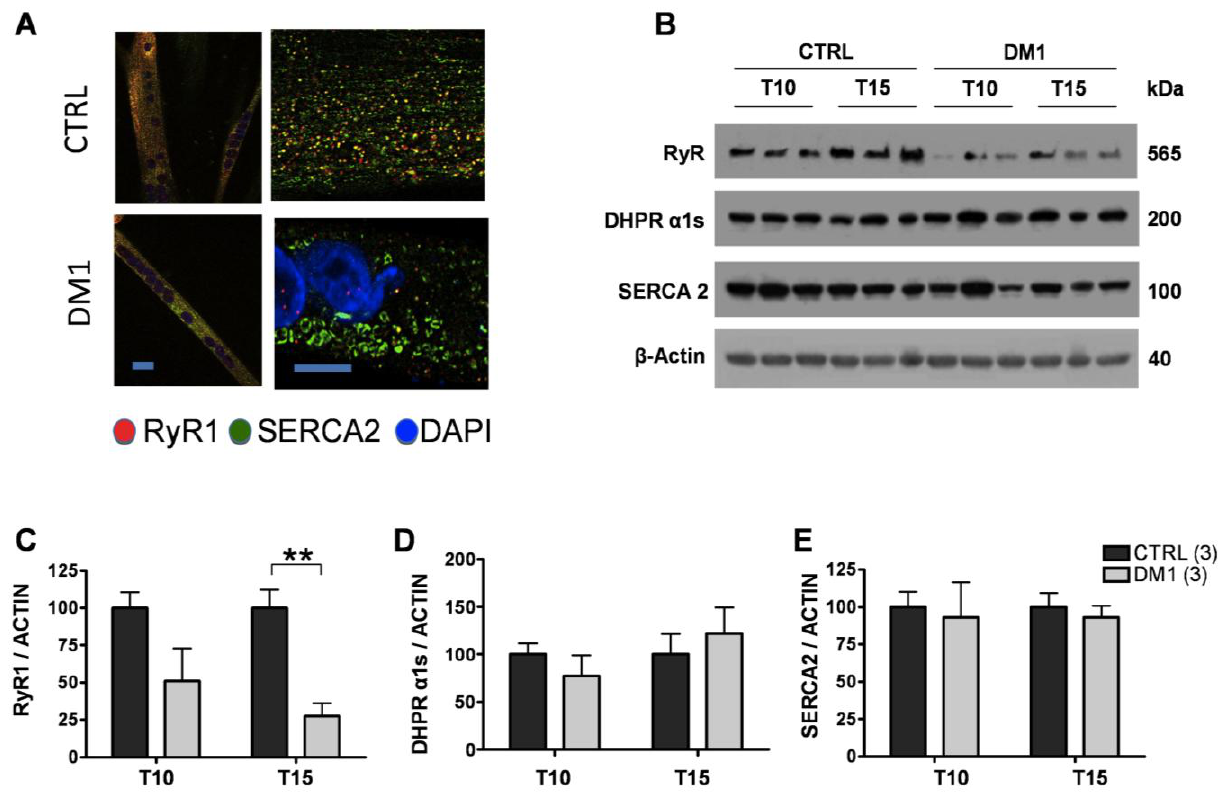
Figure 4. Expression of Ca 2+ channels and transporters in control and DM1 myotubes at 10 (T10) and 15 (T15) days of differentiation. ( A ) Representative images of SERCA2 (green) and RyR1 (red), nuclei (blue-Dapi) immunofluorescence of T15 differentiated control and DM1 myotubes. Scale bar is 10 (cid:541)(cid:80)(cid:17)(cid:3) (cid:11) B ) Representative Western blot analysis of RyR1, (cid:39)(cid:43)(cid:51)(cid:53)(cid:3) (cid:302)(cid:20)(cid:86)(cid:3) (cid:11)(cid:38)(cid:68)(cid:89)(cid:20)(cid:17)(cid:20)(cid:12)(cid:3) (cid:68)(cid:81)(cid:71)(cid:3) (cid:54)(cid:40)(cid:53)(cid:38)(cid:36)(cid:21)(cid:3) (cid:82)(cid:73)(cid:3) (cid:70)(cid:82)(cid:81)(cid:87)(cid:85)(cid:82)(cid:79)(cid:3) (cid:68)(cid:81)(cid:71)(cid:3) (cid:39)(cid:48)(cid:20)(cid:3) (cid:80)(cid:92)(cid:82)(cid:87)(cid:88)(cid:69)(cid:72)(cid:86)(cid:3) (cid:68)(cid:87)(cid:3) (cid:20)(cid:19)(cid:3) (cid:68)(cid:81)(cid:71)(cid:3) (cid:20)(cid:24)(cid:3) (cid:71)(cid:68)(cid:92)(cid:86)(cid:3) (cid:82)(cid:73)(cid:3) differentiation. ( C (cid:177) E (cid:12)(cid:3) (cid:52)(cid:88)(cid:68)(cid:81)(cid:87)(cid:76)(cid:73)(cid:76)(cid:70)(cid:68)(cid:87)(cid:76)(cid:82)(cid:81)(cid:3) (cid:82)(cid:73)(cid:3) (cid:53)(cid:92)(cid:53)(cid:20)(cid:15)(cid:3) (cid:39)(cid:43)(cid:51)(cid:53)(cid:302)(cid:20)(cid:86)(cid:3) (cid:68)(cid:81)(cid:71)(cid:3) (cid:54)(cid:40)(cid:53)(cid:38)(cid:36)(cid:21)(cid:3) (cid:83)(cid:85)(cid:82)(cid:87)(cid:72)(cid:76)(cid:81)(cid:3) (cid:79)(cid:72)(cid:89)(cid:72)(cid:79)(cid:86)(cid:3) (cid:81)(cid:82)(cid:85)(cid:80)(cid:68)(cid:79)(cid:76)(cid:93)(cid:72)(cid:71)(cid:3)(cid:87)(cid:82)(cid:3)(cid:533) -actin. Data are the mean ± SD of two experiments. ** p < 0.01 as compared (cid:87)(cid:82)(cid:3)(cid:70)(cid:82)(cid:81)(cid:87)(cid:85)(cid:82)(cid:79)(cid:86)(cid:3)(cid:69)(cid:92)(cid:3)(cid:54)(cid:87)(cid:88)(cid:71)(cid:72)(cid:81)(cid:87)(cid:86)(cid:182)(cid:3) t test. The numbers of single lines studied is given in